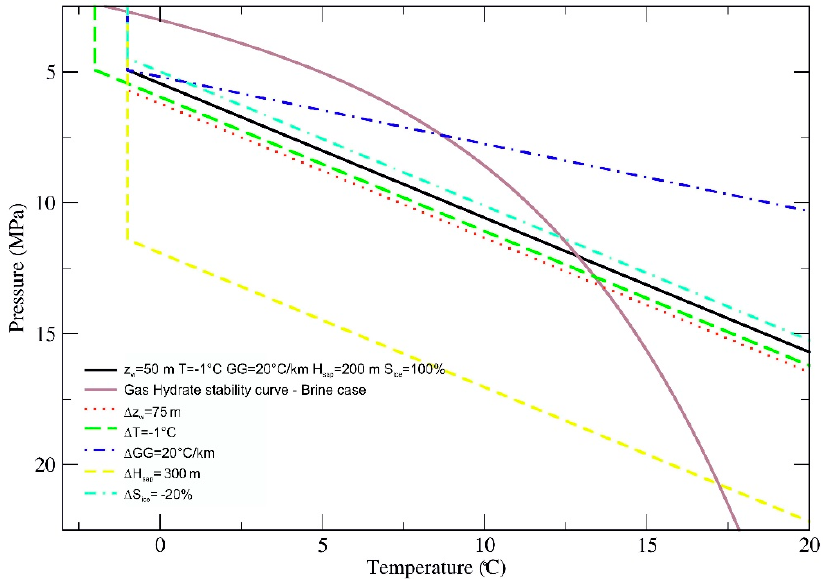
Figure 1. Thickness of the gas hydrate stability zone (GHSZ) for different combinations of controlling parameters in the marine environment (brine with 3.5 wt.% salinity). The black solid line represents the reference case. The other curves represent a variation of one parameter with respect to the reference case. Red dotted line: Δ z w = 75 m. Green dashed line: ΔΤ = − 1 °C. Yellow dashed line: Δ H SAP = 300 m. Light-blue dashed-dotted line: Δ S ice = − 20%. Δ means variation with respect to the reference case. Explanation of the parameters is reported in the text.